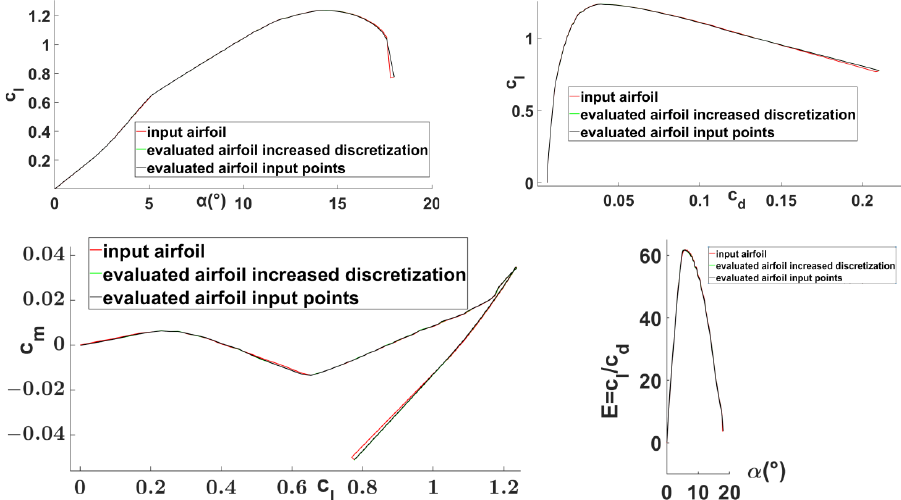
Figure 19. NACA 0012 input airfoil, evaluated airfoil, evaluated airfoil increased discretization (140 points) 𝑐 𝑙 (𝛼),𝑐 𝑙 (𝑐 𝑑 ) 𝑐 𝑚 (𝑐 𝑙 ),𝐸(𝛼) = 𝑐 𝑙 (𝛼) 𝑐 𝑑 (𝛼)⁄ comparison.